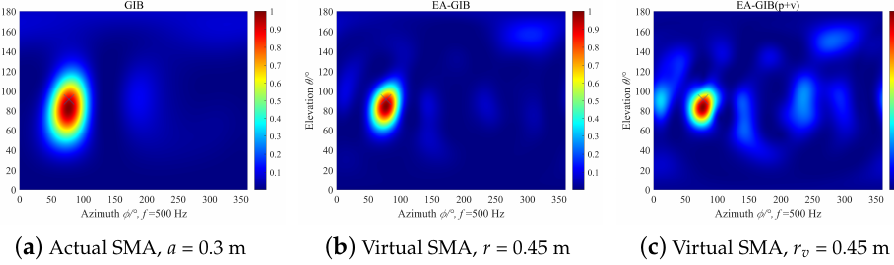
Figure 10. Experiment data processing results of the single sound source with the frequency 125 Hz.